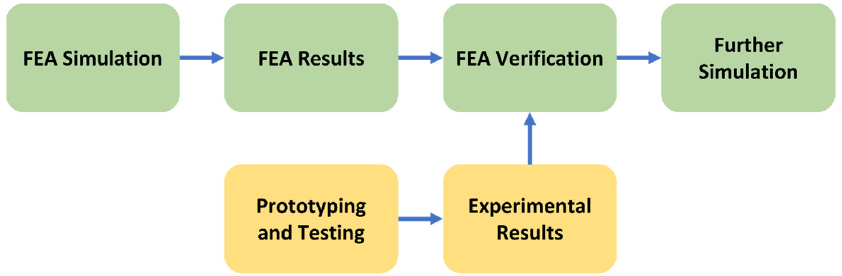
Figure 1. Block diagram showing methodology of FEA simulation and validation of simulation using an experimental prototype.